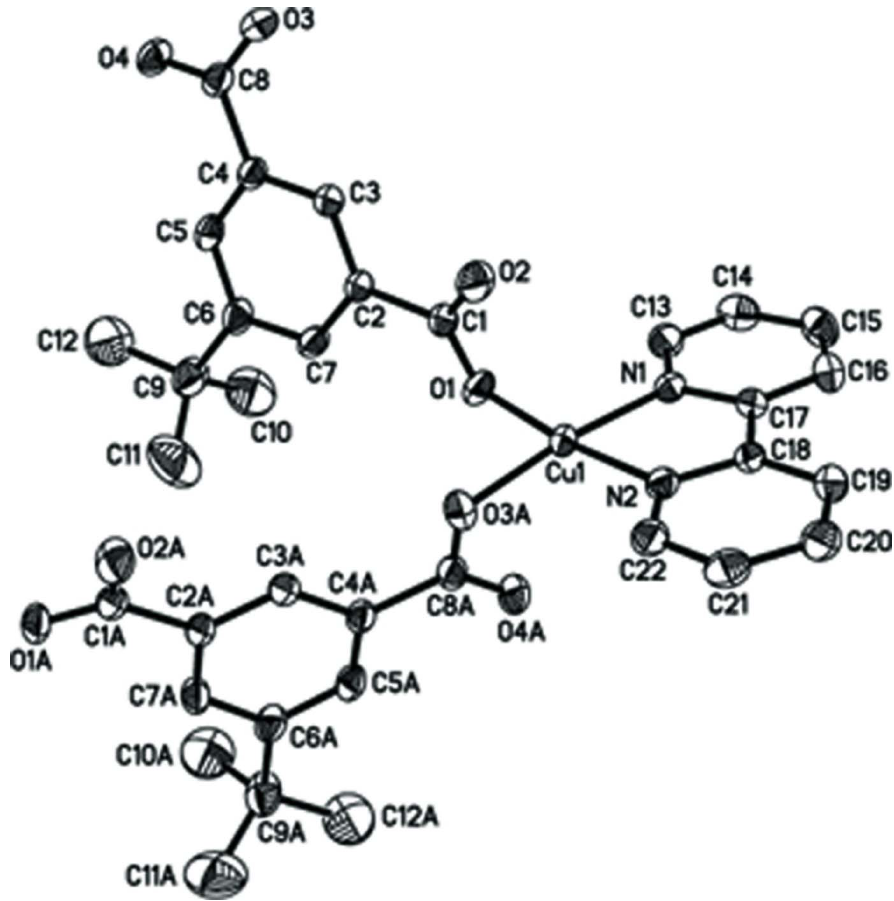
Figure 1 A view of the asymmetric unit of compound (I), with thermal ellipsoids drawn at the 50% probability level. H atoms have been omitted for clarity. Atoms with label A are related to those without by symmetry operation ( x , - y +1.5, z